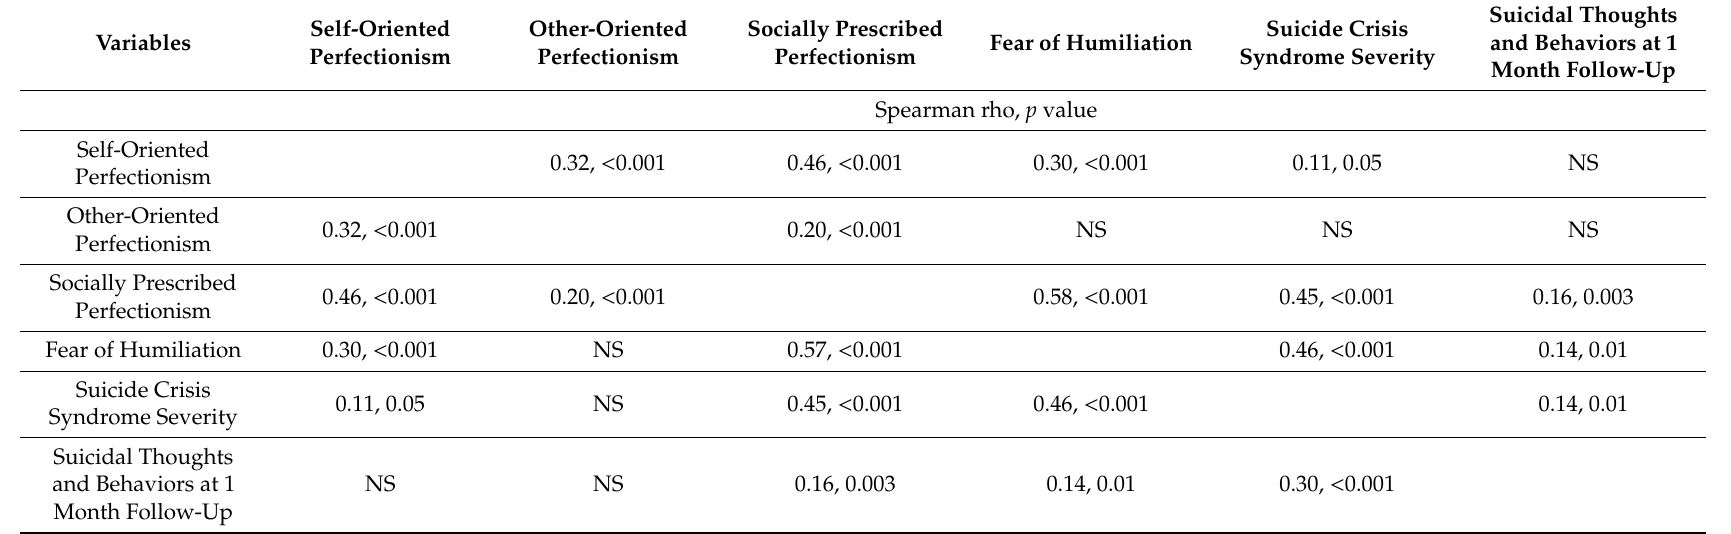
Table 2. Spearman rho correlations between Perfectionism, Fear of Humiliation, Severity of the Suicide Crisis Syndrome, and Suicidal Thoughts and Behaviors at 1 month follow